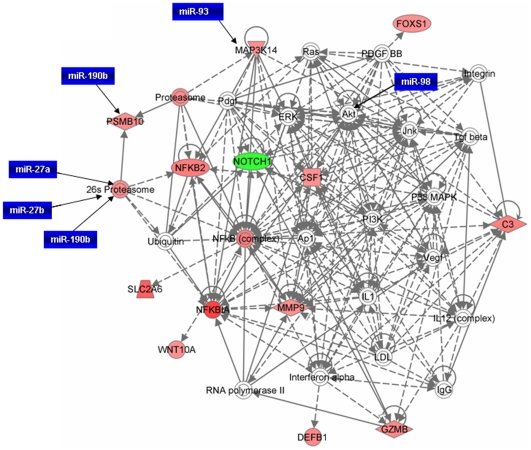
Network of genes up-regulated by TWEAK in microarray experiment.NF-κB and proteasome pathways are major pathways affected by differentially regulated genes by TWEAK. Although many of the microRNAs differentially expressed by TWEAK may not be targeting the differentially regulated genes directly, they can regulate indirectly through other intermediary molecules. For example let-7a and miR-98 may have an indirect effect on expression of Nocth1 by regulating Akt pathway. The solid lines connecting molecules here represent a direct relation and dotted lines an indirect relation. The gene network presented here was adopted from Ingenuity pathway analysis tool with differentially regulated genes by TWEAK with p-values ≤0.05 and ≥1.5-fold. The genes shown in red are up-regulated in microarray data whereas down-regulated genes are shown in green color. Differentially expressed miRNAs (in blue colored boxes) having their putative targets are superimposed on the network.